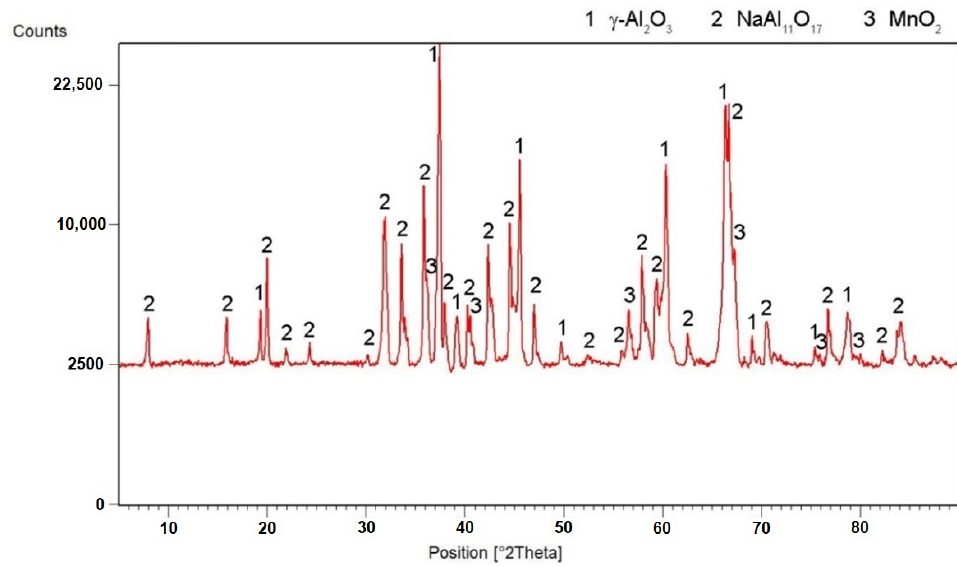
Figure 17. X-ray diffraction pattern of the slag.